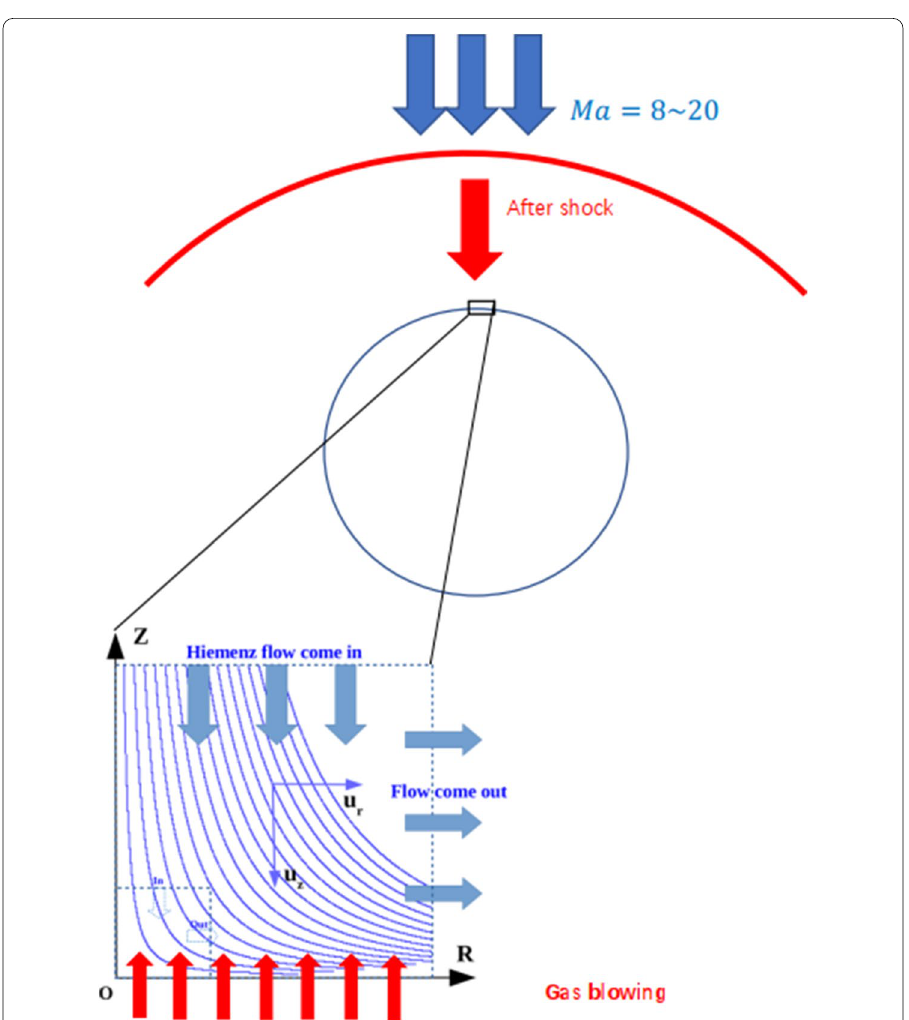
Fig. 1 The schematic of the head of a hypersonic vehicle in a typical incoming